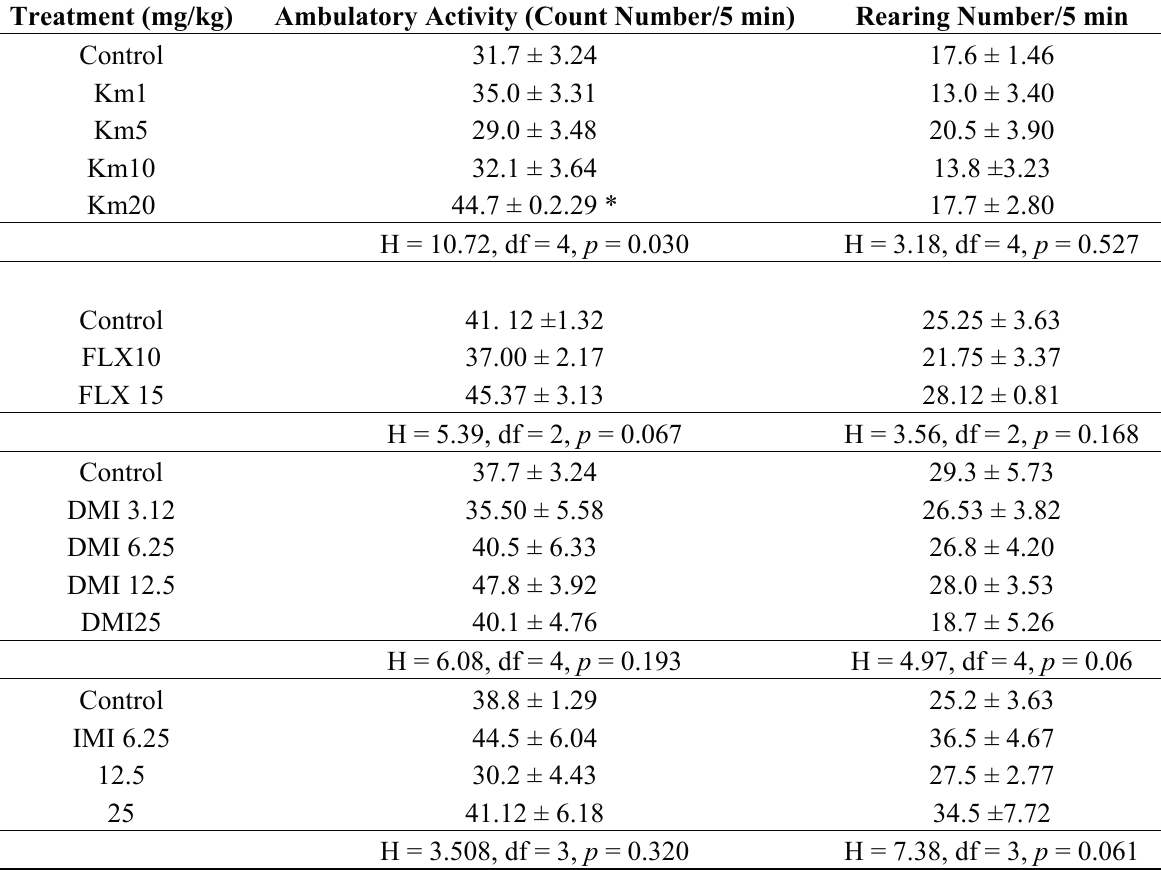
Table 1. Effects of Km, FLX, DMI, and IMI on open field test